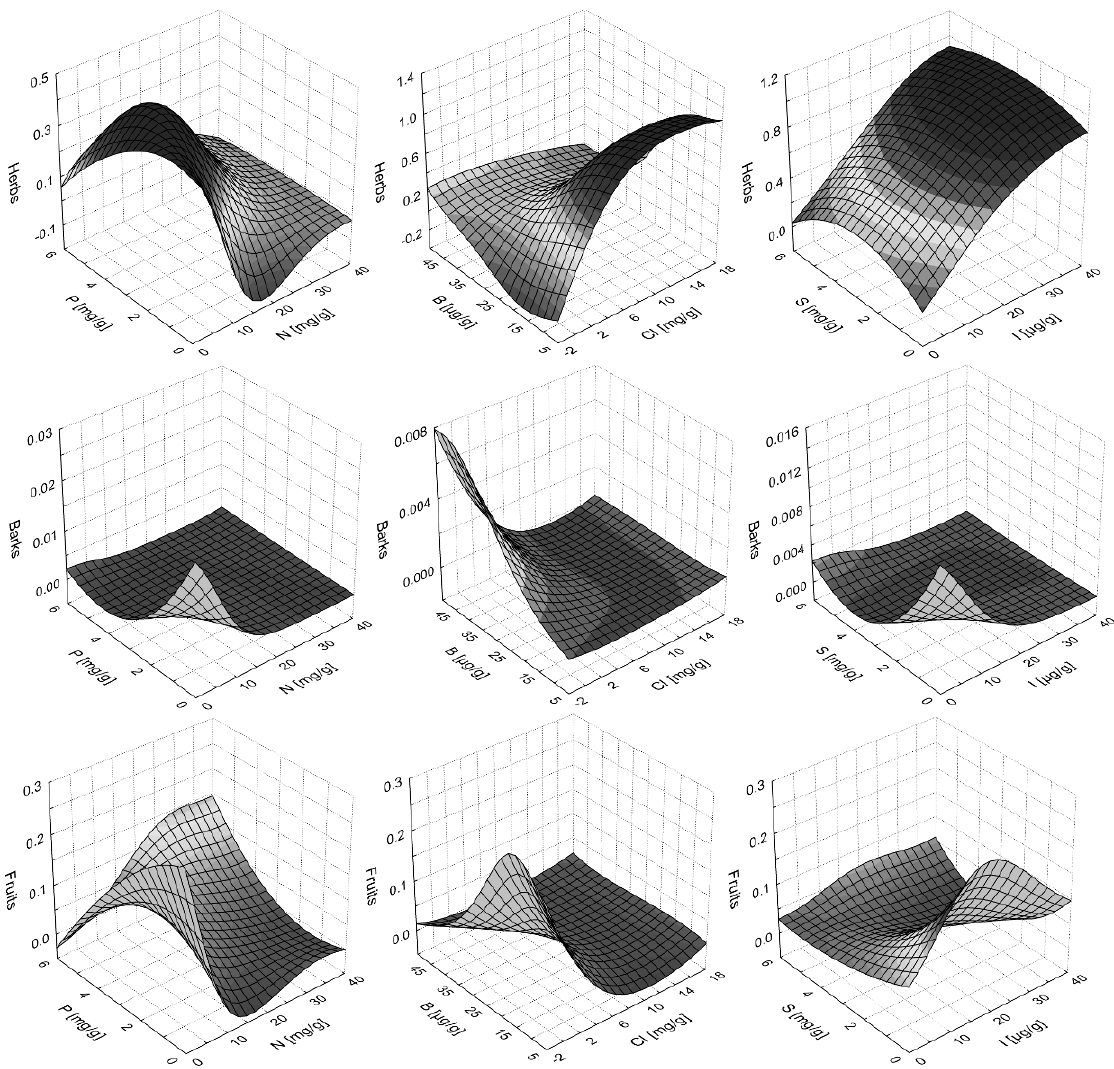
Figure 3. MLP response surfaces for herbs, barks and